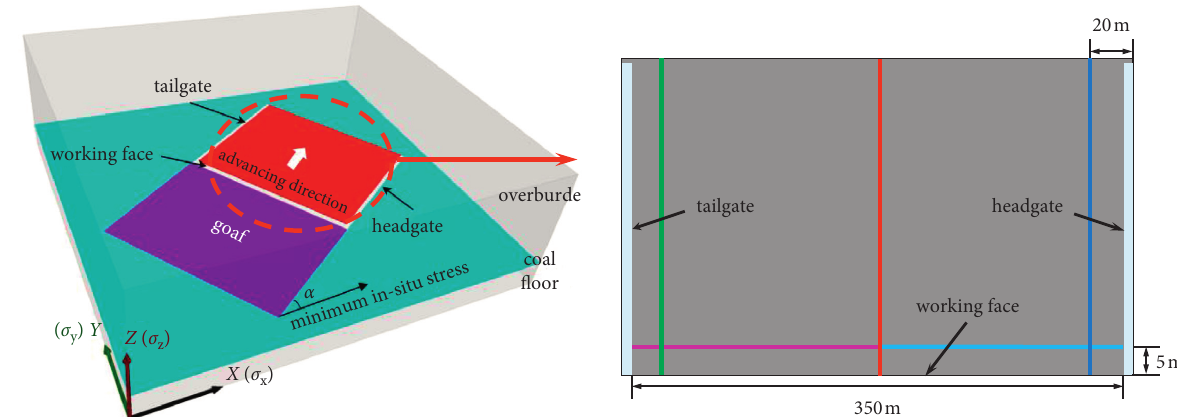
Figure 5: Numerical calculation model and the location of measuring line.